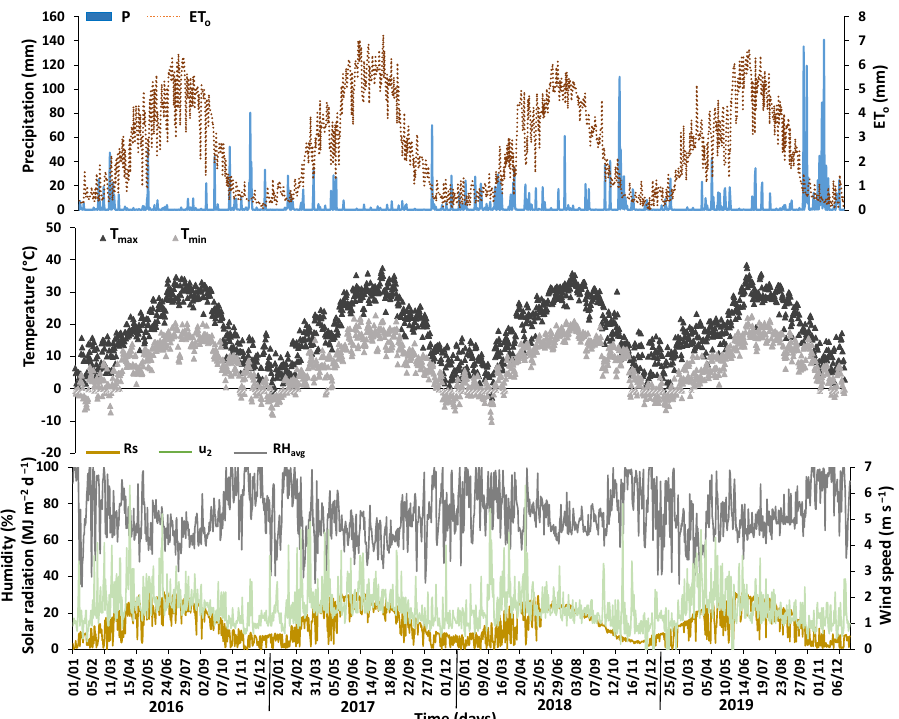
Figure 1. Weather data for Monferrato plots during the study period (P, precipitation, ET o , reference evapotranspiration; T max and T min , maximum and minimum air temperatures, RH avg , mean relative humidity; R s , solar radiation, u 2 , wind speed at 2 m height).